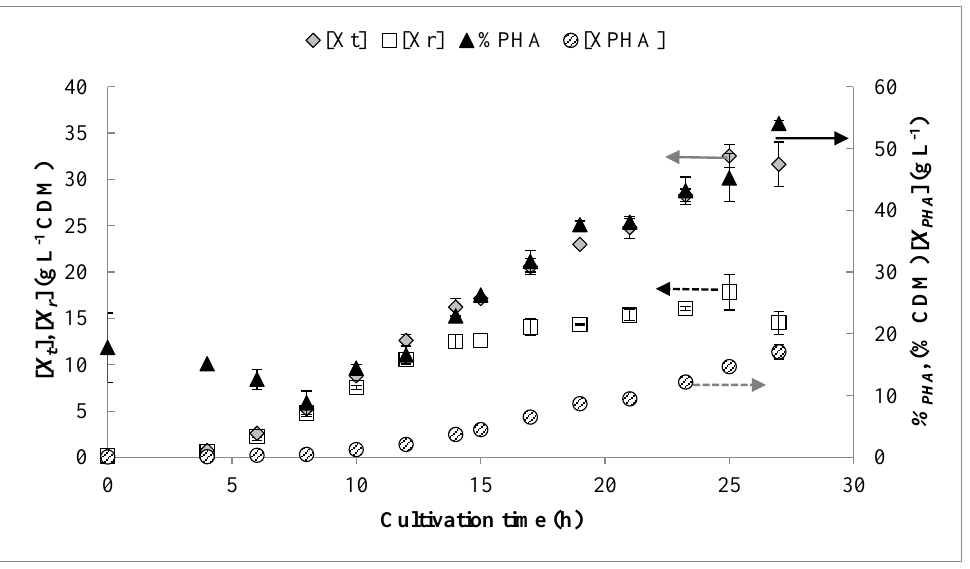
Figure 3. Modeled cumulative feeding of carbon and ammonium over the time course of the pulse feed experiments. Error bars represent standard deviations between three biological replicates.